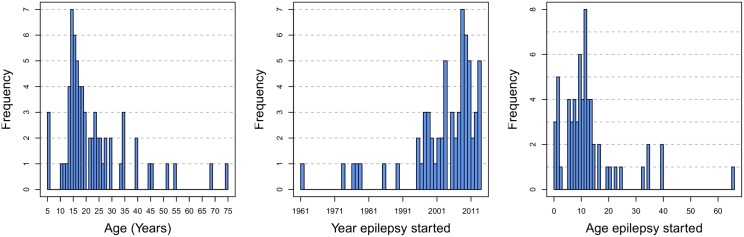
From left to right: the age distribution of epileptics in Dingila, the year their epilepsy started, and their age upon first epilepsy seizure.